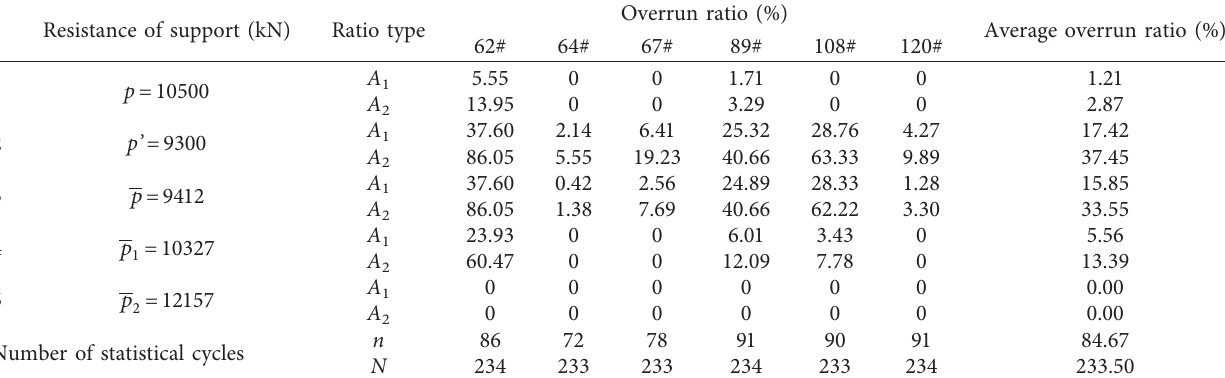
Table 7: Ratio of end cycle resistance exceeding 5 resistance values for 6 key